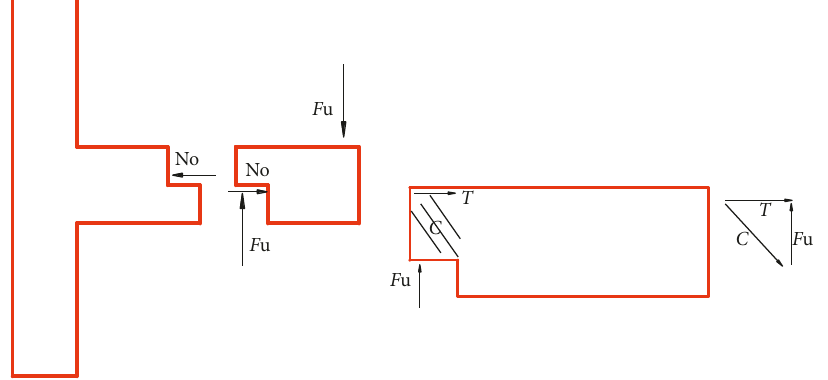
Figure 3: Calculation